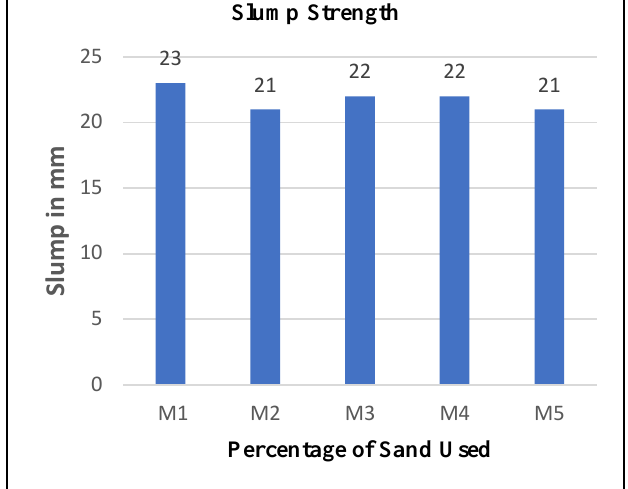
Fig. 7. Slump test 4.3 Density Fig. 8 highlights the results of the density of concrete made with hill and desert sand. It demonstrates that concrete’s density decreases as the amount of desert sand rises. The (M1) made with hill sand has the highest density, while M5 made with desert sand has the lowest density around 2.14% less dense than M1 made with hill sand. The findings show unequivocally that desert sand has little to no impact on the density of concrete.